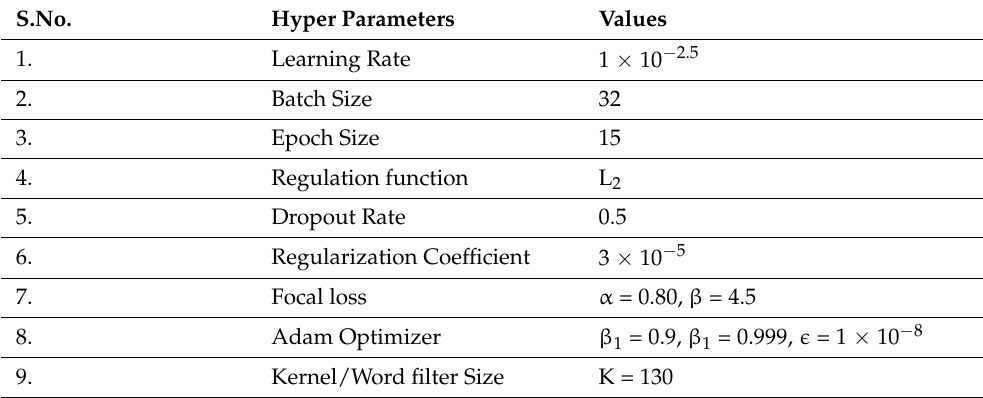
Table 2. Hyperparameters and their values used by proposed